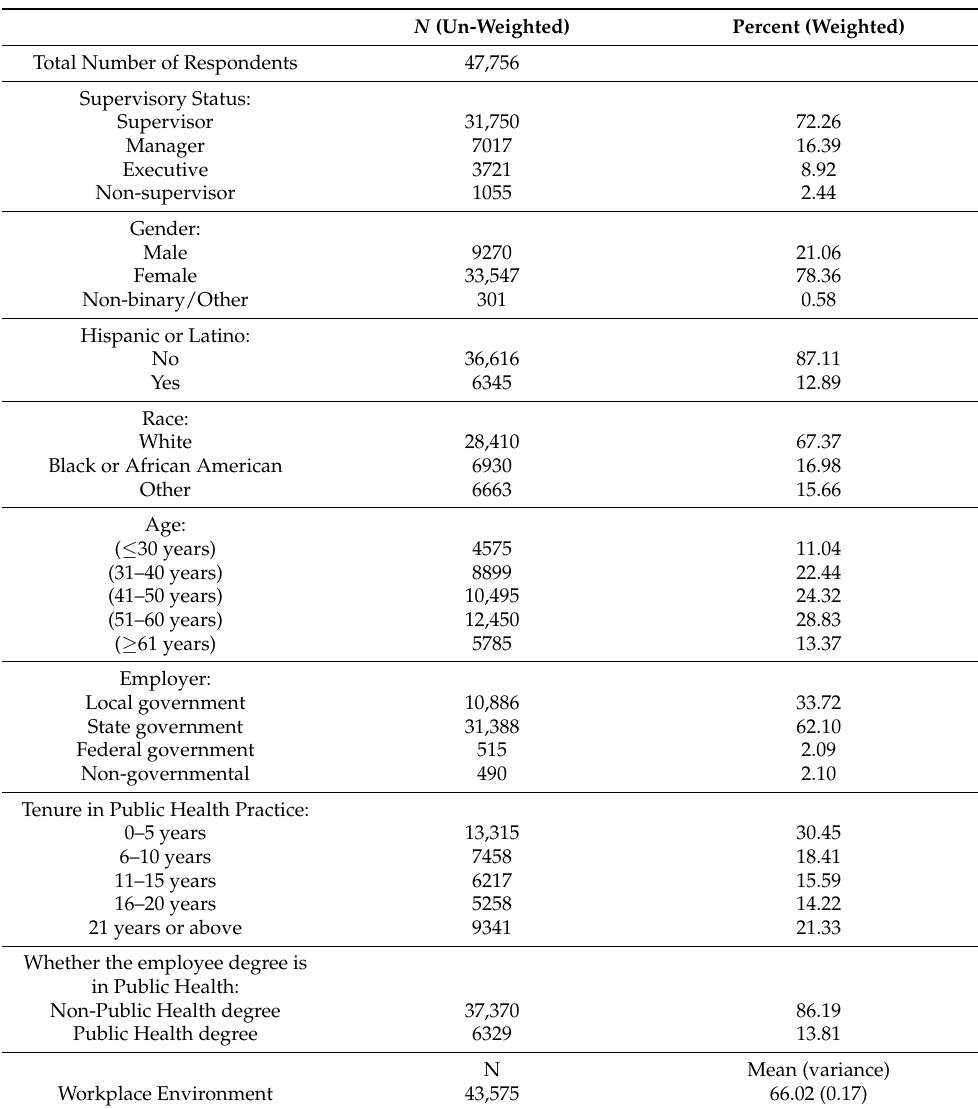
Table 1. Public health workforce descriptive statistics, 2017 Public Health Workforce Interests and Needs Survey (PH